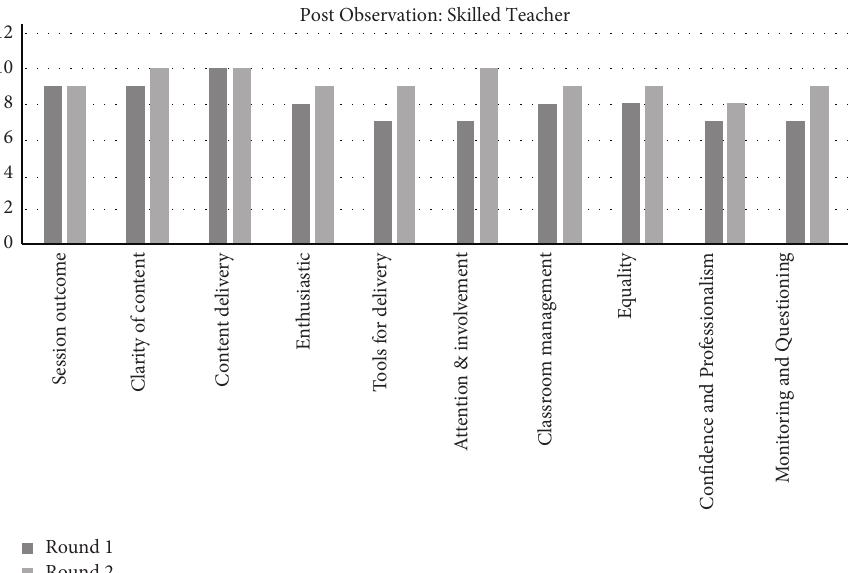
Figure 4: Peer observation by skilled teachers in round 1 (dark grey bars) and round 2 (light grey bars).